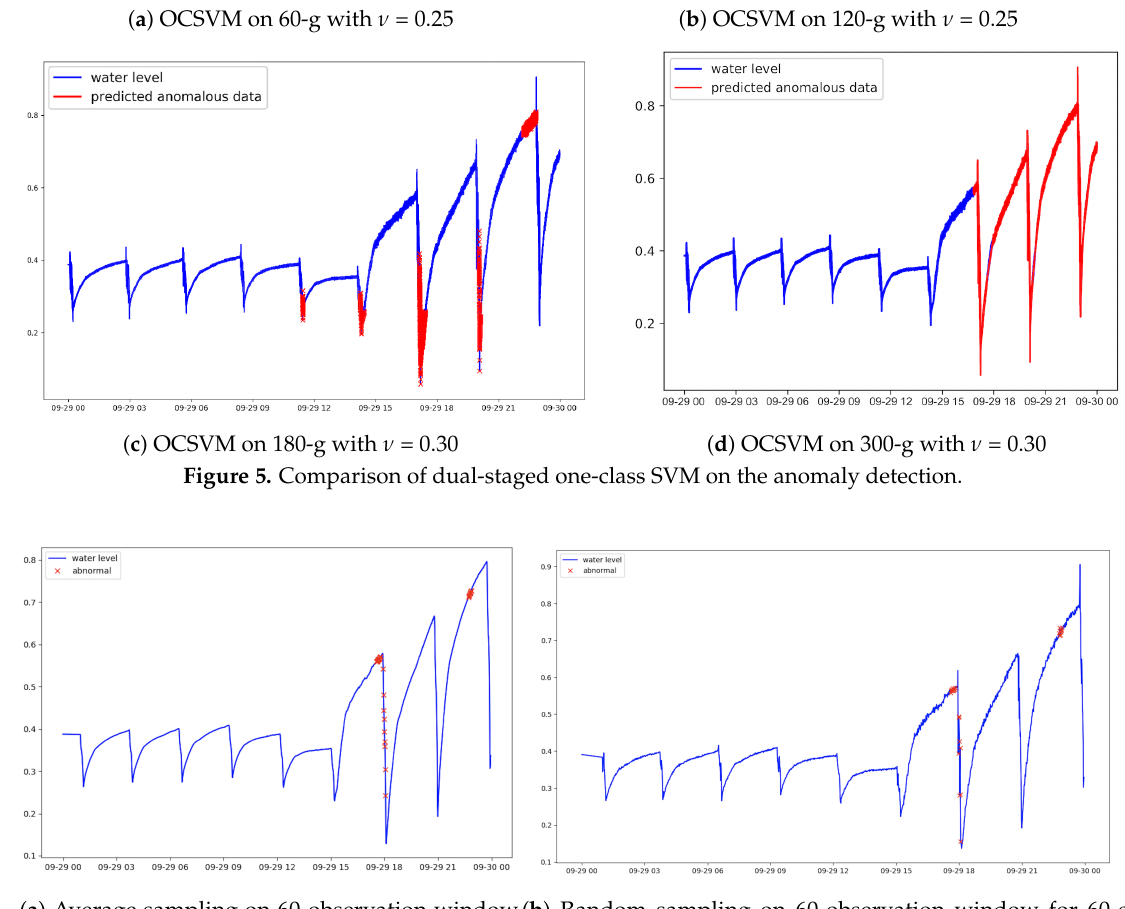
Figure 6. Comparison of sampling techniques (average and random) of 60-observations window on the